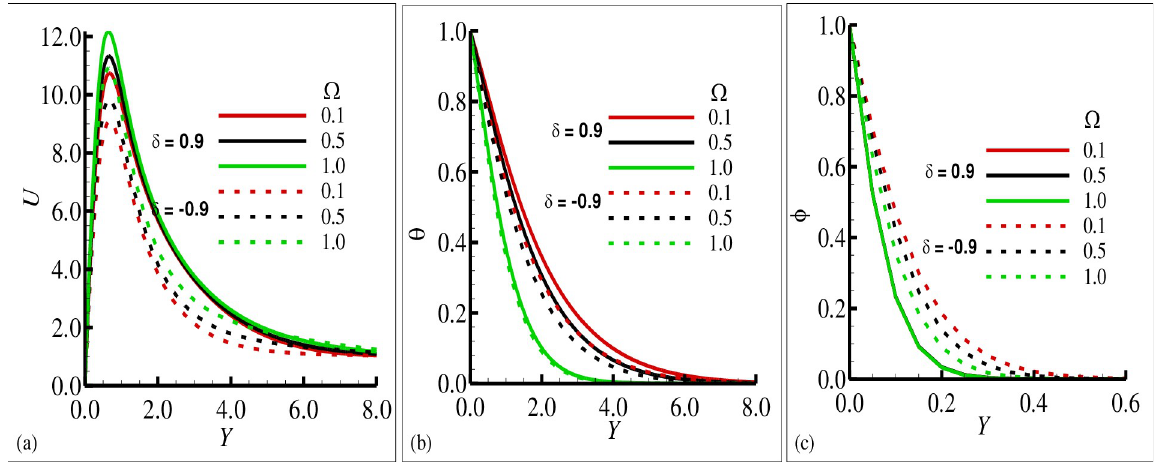
Fig 5. The graphical results for (a) velocity field u , (b) temperature field θ , and (c) magnetic field ϕ with the choice values of O = 0.1, 0.5, 1.0 for heat source δ = 0.9 and sink δ = − 0.9, where others are γ = 0.4, Pr = 7.0, ξ = 0.5 and λ = 0.1.